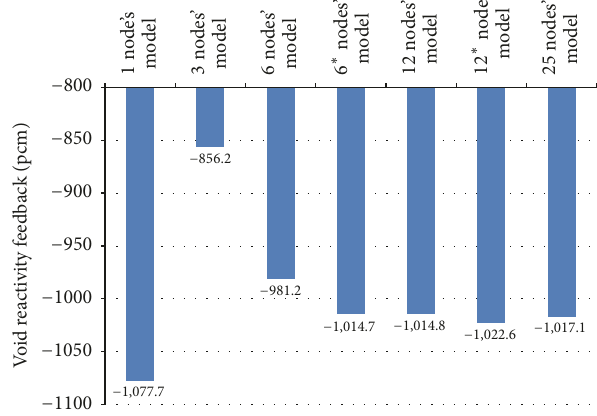
Figure 6: Void reactivity feedback calculated using different nodalisation